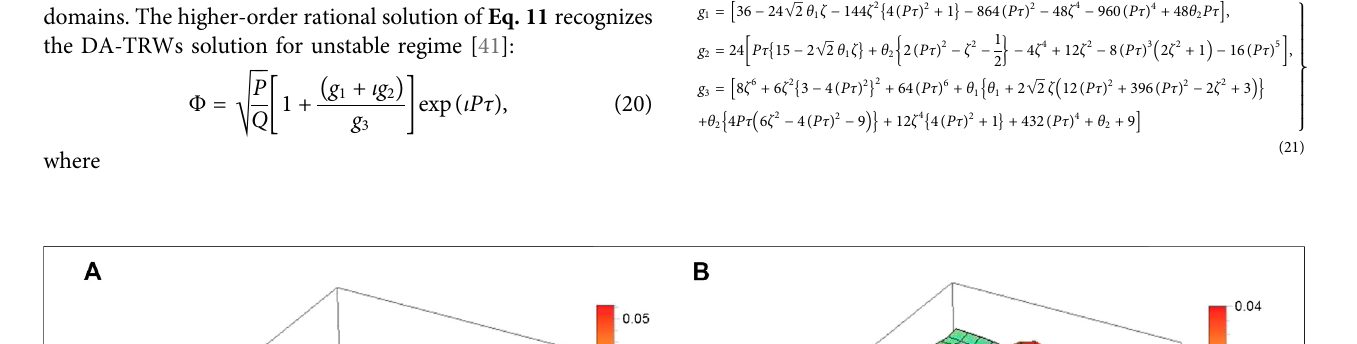
Frontiers in Physics |